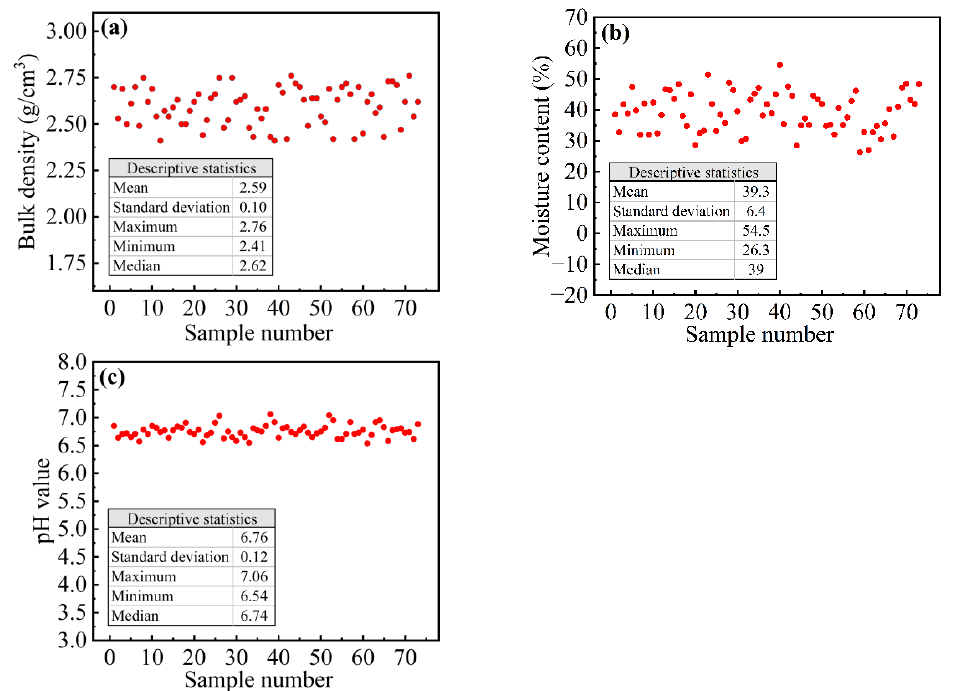
Figure 2. ( a ) Bulk density, ( b ) moisture content, and ( c ) pH value of sewer sediment samples.